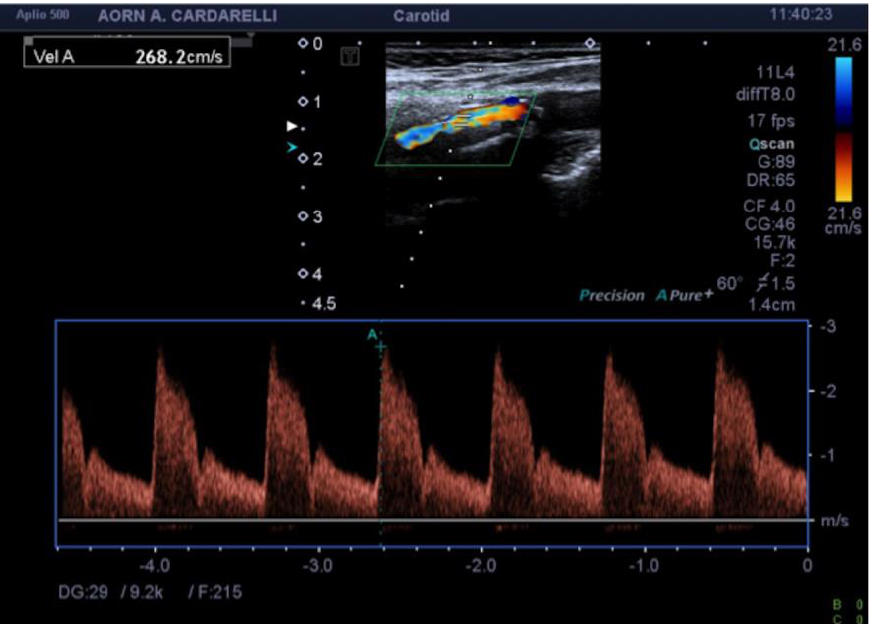
Figure 3. CDUS shows evidence of high grade stenosis (>70%) of a right internal carotid artery stenosis with aliasing at colormap (top) and increased systemic peak velocity to spectral flow analysis (below).